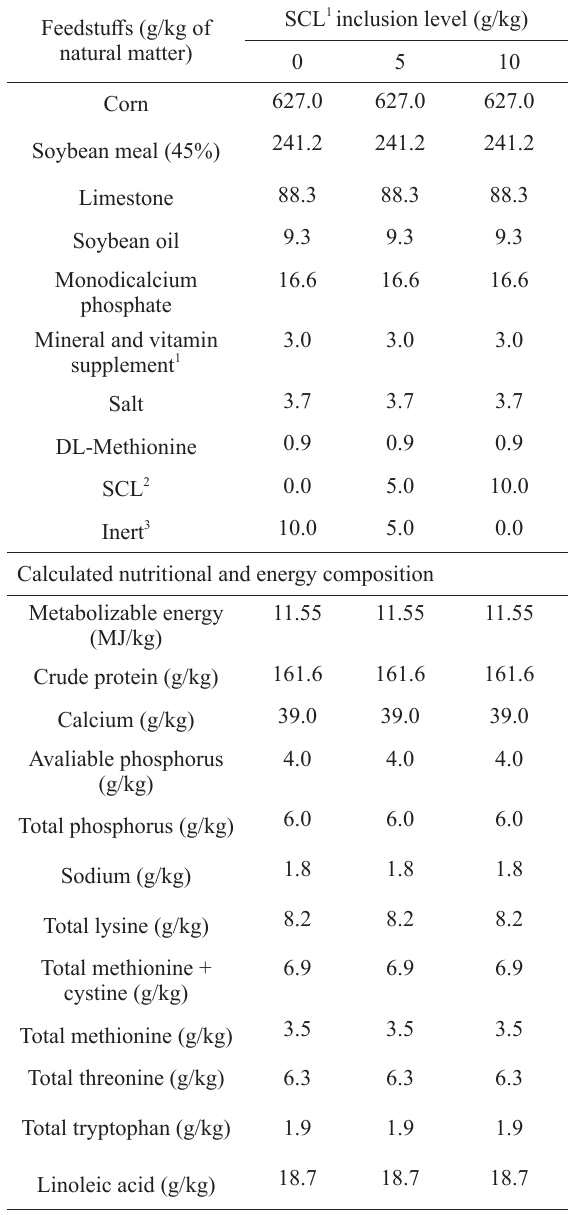
Composition of diets according to SCL inclusion